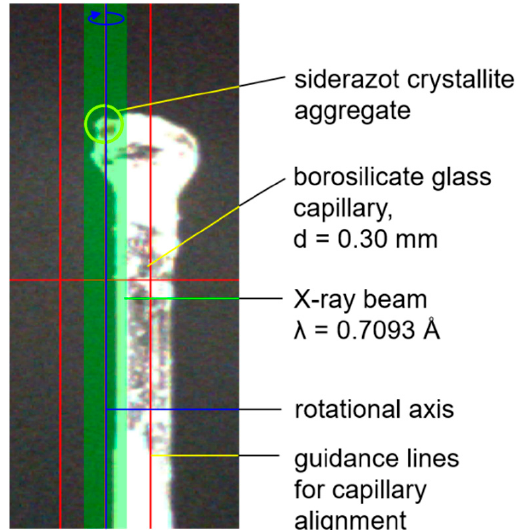
Figure 1. Experimental setup for collecting powder X-ray diffraction (PXRD) data of the siderazot mineral sample on a Stoe Stadi P powder diffractometer (Debye–Scherrer geometry) using Mo- K α 1 radiation.